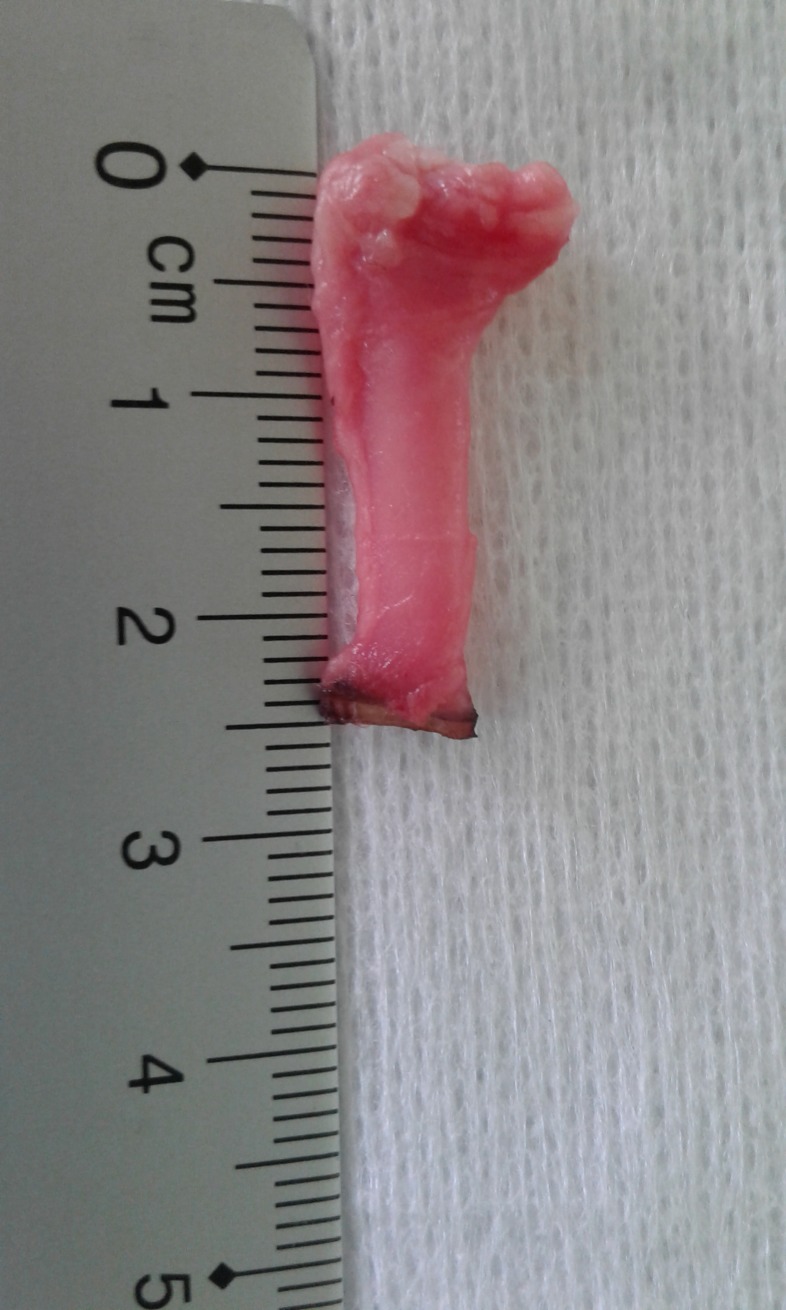
Sealed renal artery.